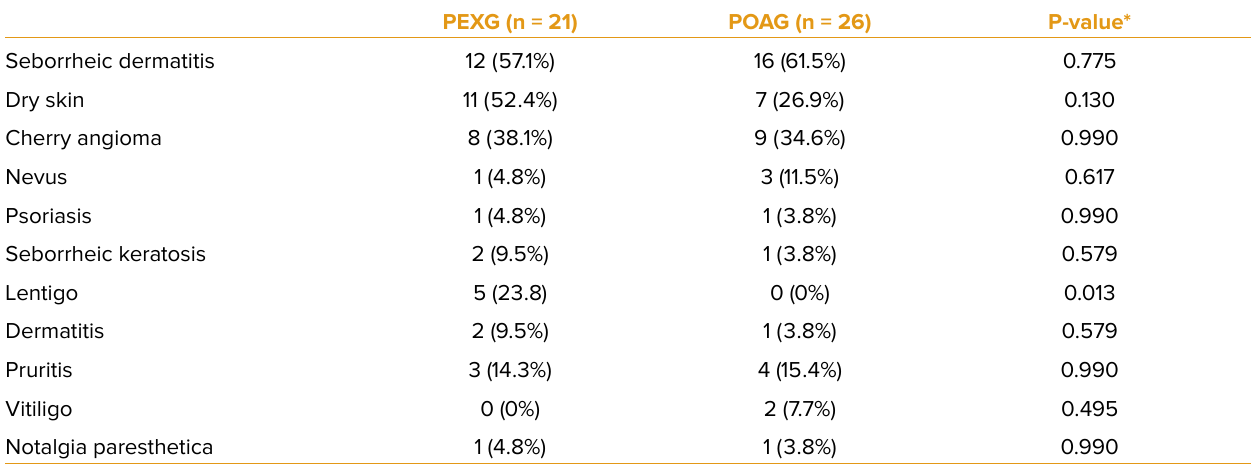
Table 2. Frequency of dermatologic manifestations in the study